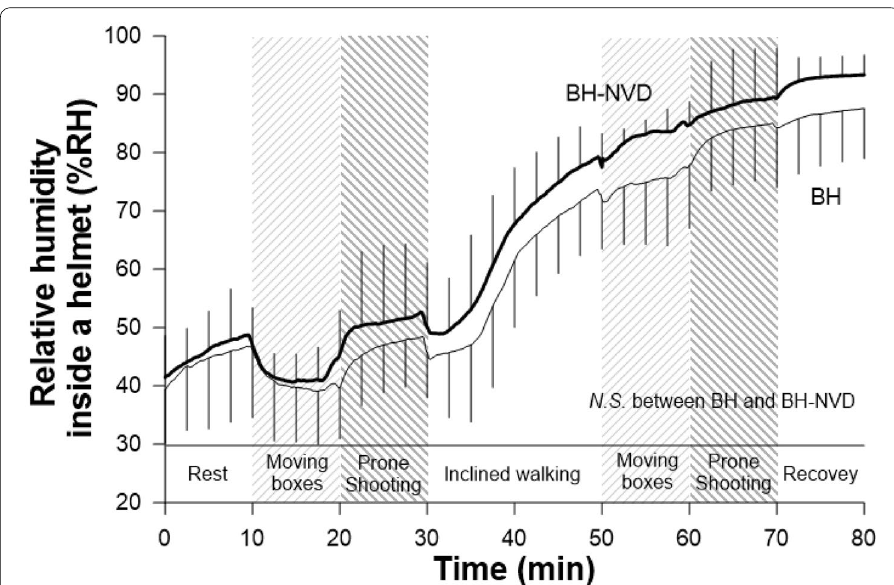
Fig. 3 Changes in the relative humidity inside a helmet in both conditions during entire protocol. No significance (N.S.) was found between BH and BH_NVD by Wilcoxon signed rank test (N